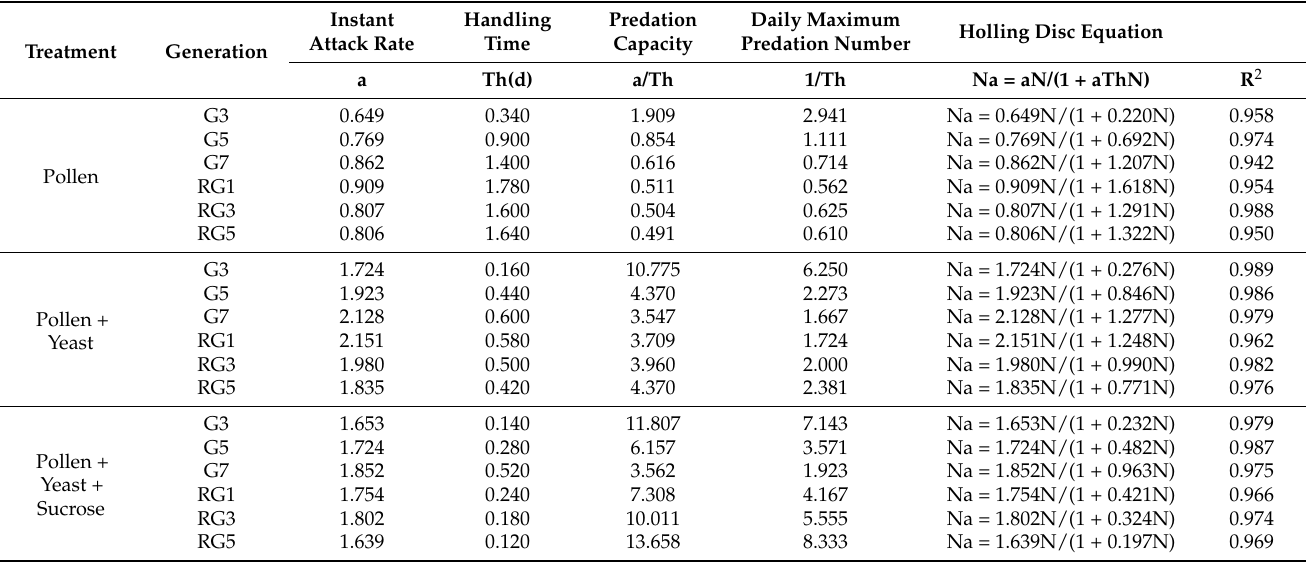
Table 4. The functional response of Amblyseius orientalis to Panonchus citri in the different treatment groups.